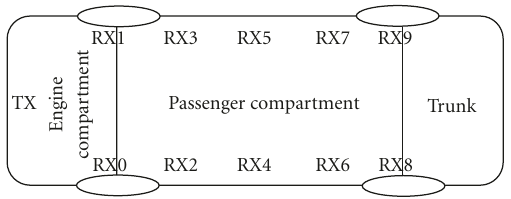
Figure 4: Antenna locations for the measurements beneath the